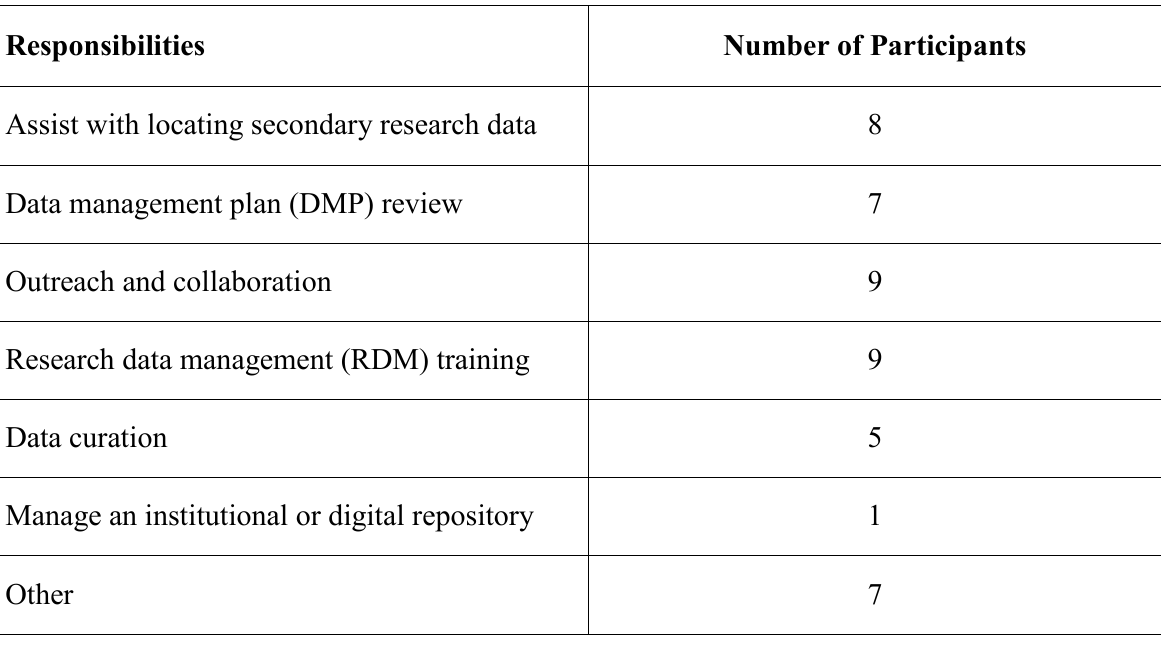
Table 1 : Primary job duties as